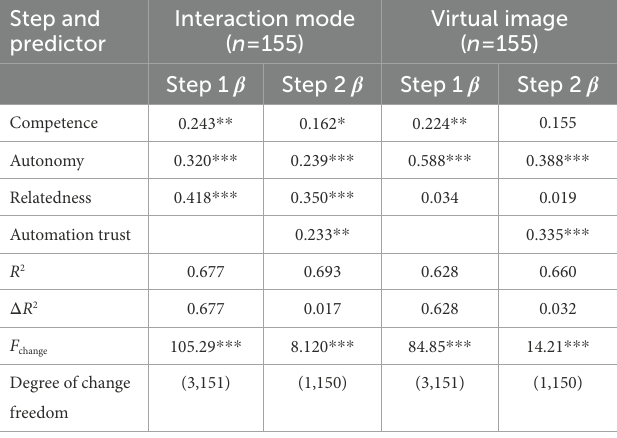
TABLE 7 Hierarchical regression analyzes: predicting intention to use interaction technology. Step and predictor